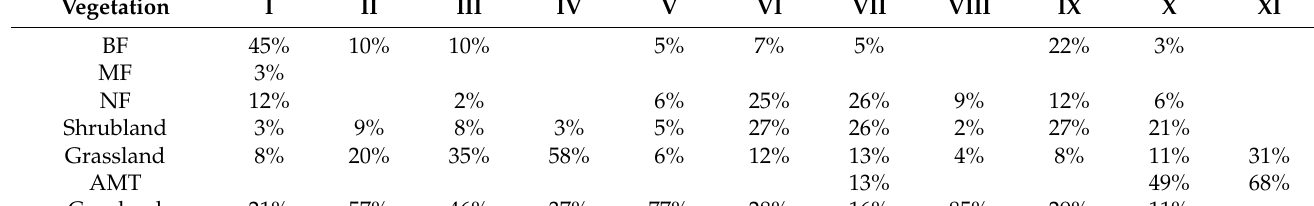
Table 3. Percentages of main vegetation types (broadleaf forest (BF), mixed forest (MF), needleleaf forest (NF), shrubland, grassland, alpine meadows and tundra (AMT), cropland, swamp) in each sub-region.